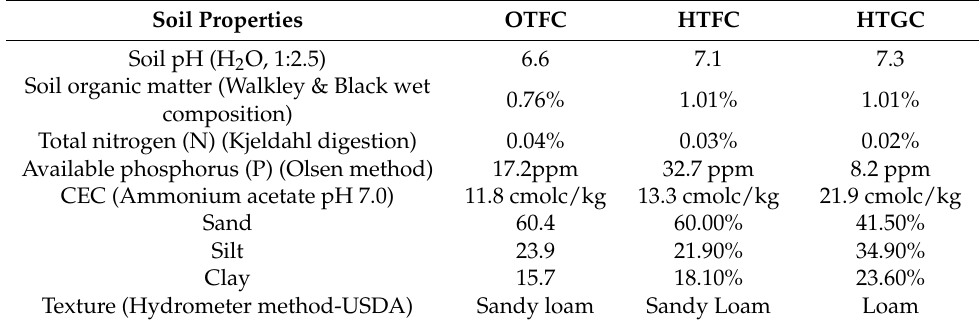
Table 5. Soil properties of the field and greenhouse environmental